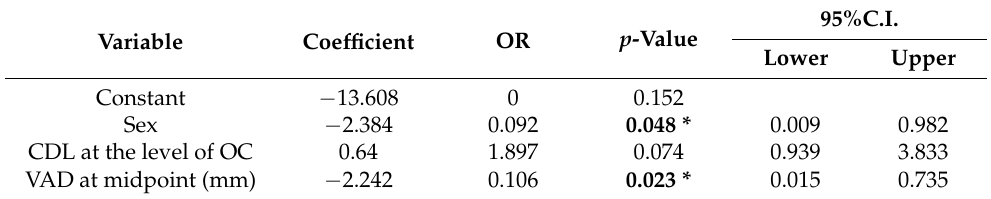
Table 3. Logistic regression analysis to model the chance of no